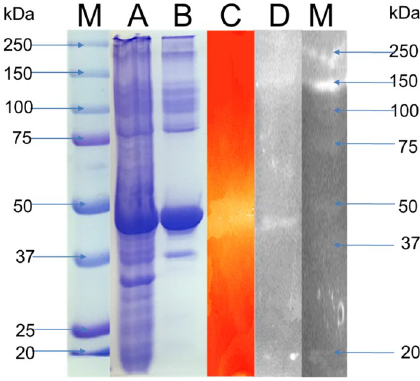
Figure 6. SDS PAGE, and zymogram analysis of the xylanase resolved on the 12.5% polyacrylamide gel. Lane M: Biorad precision plus standard protein marker; lane A: Crude enzyme; lane B Concentrated supernatant; lane C: Zymogram for the xylanase; lane D: SDS PAGE analysis of the xylanase grown on PCG with silver staining.